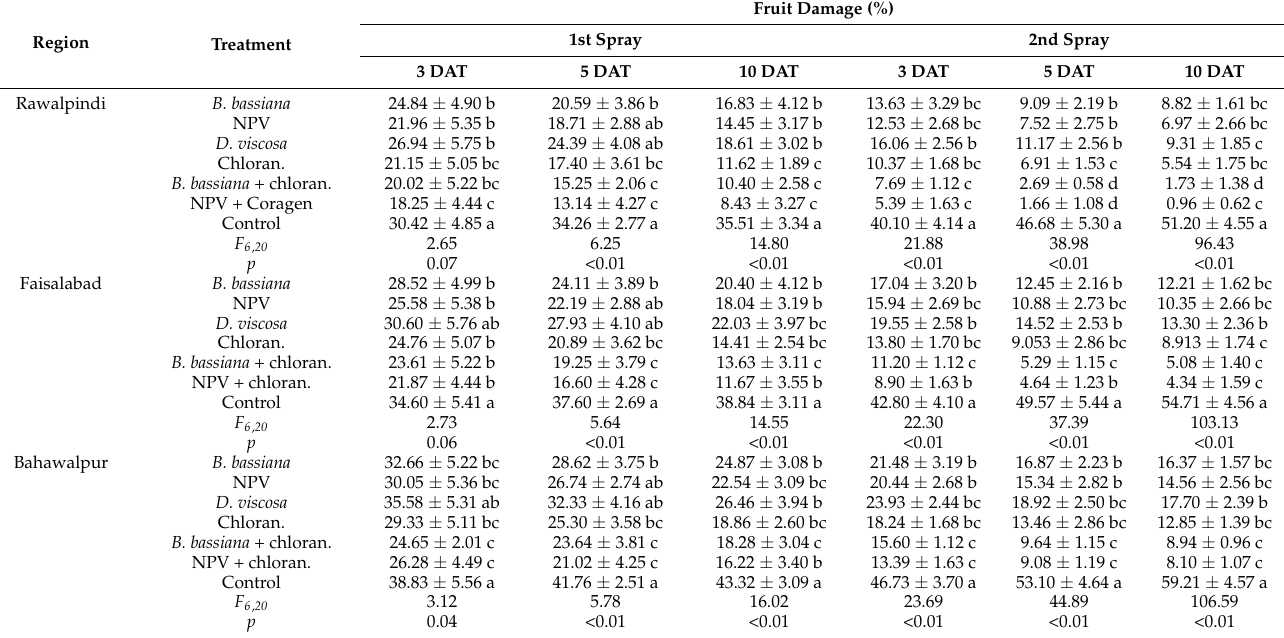
Table 4. Fruit damage (% ± SE) caused by H. armigera larvae following field application of different biorational and chemical control options based on B. bassiana ; HaNPV; D. viscosa and chlorantranilip- role (chloran.). Means within each observation followed by the same letters are not significantly different from each other (transformed values); Tukey-Kramer HSD test at p =